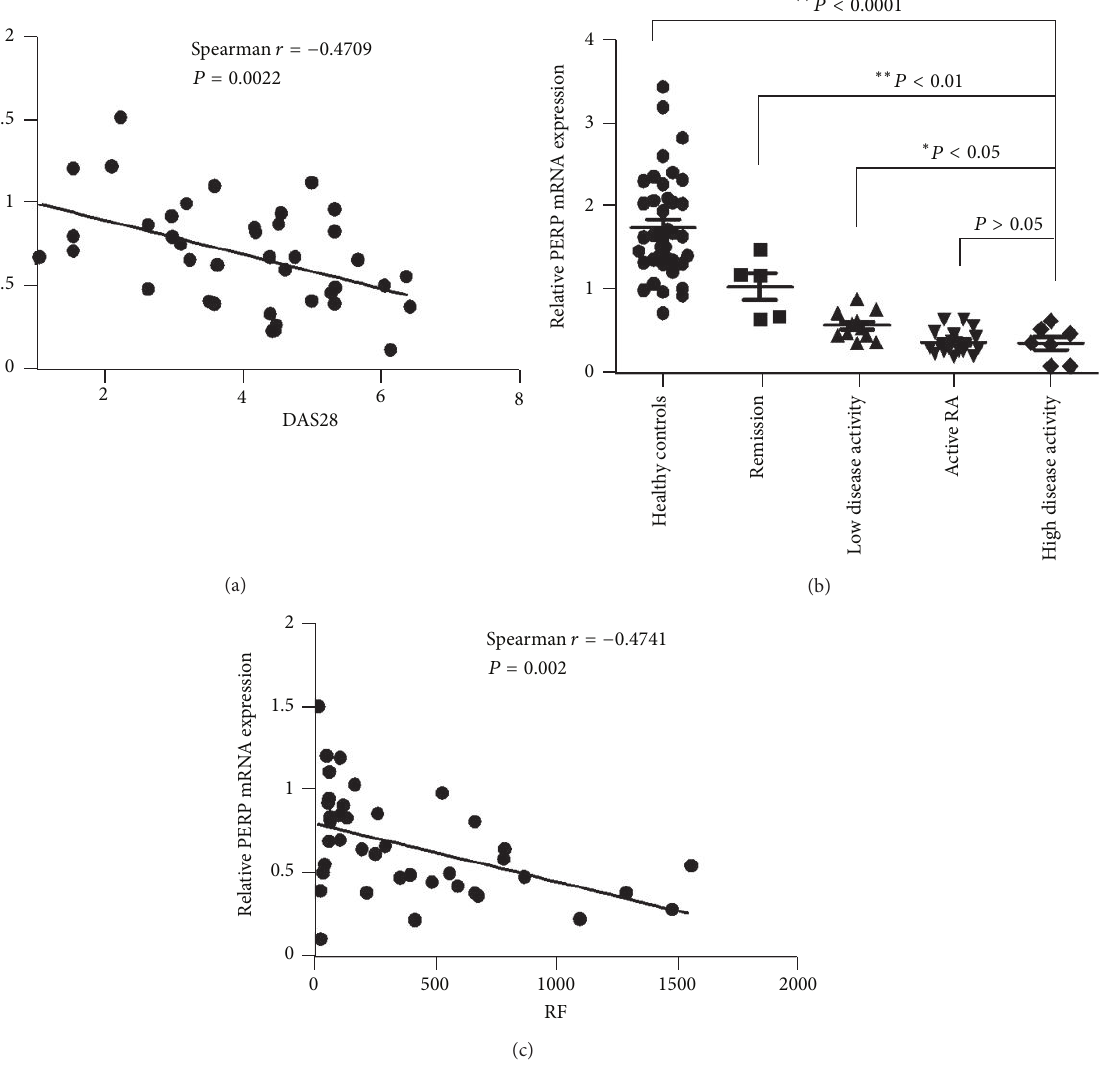
Figure3:CorrelationsofPERPmRNAexpressiononPBMCsinRApatientswithDAS28andRF.PERPmRNAtranscriptsnegativelycorrelate with disease activity score (DAS28) (a) ( 𝑃 < 0.01 ) and rheumatoid factor (RF) (c) ( 𝑃 < 0.01 ). (b) The expression levels of PERP of PBMCs from healthy controls (HCs; 𝑛 = 40 ) and RA patients in different stages of disease activity determined by DAS28. 𝑃 < 0.05 deems significantly